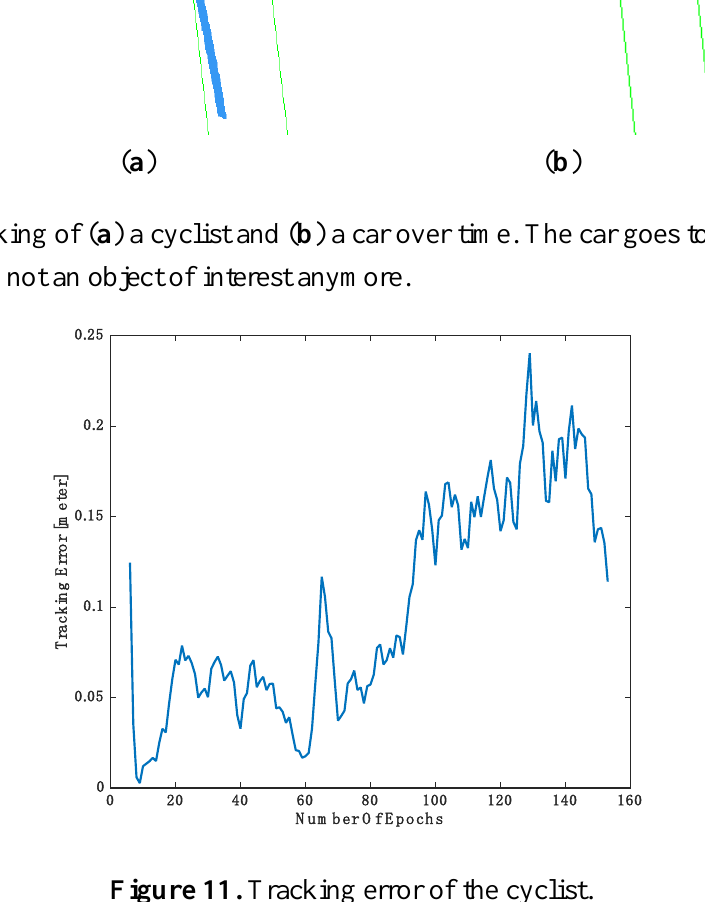
Figure 11. Tracking error of the